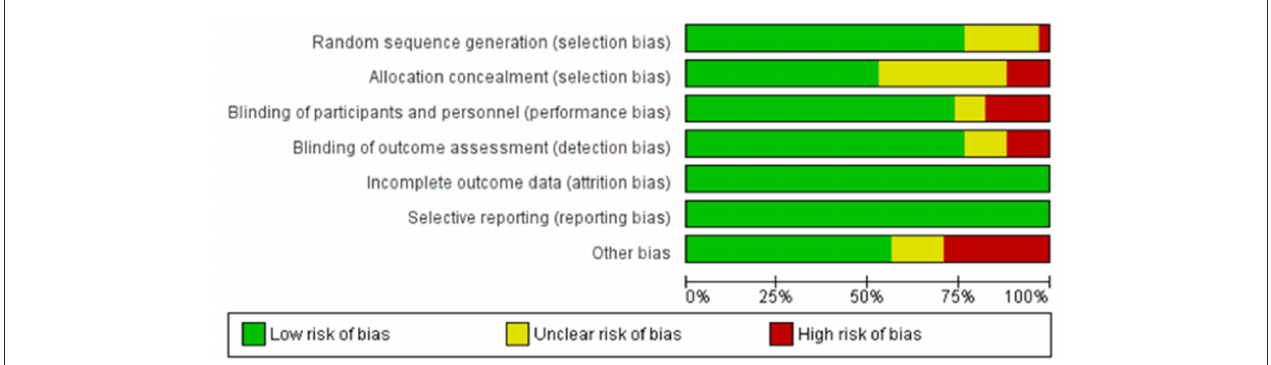
FIGURE 3 | Summary Graph for the risk of bias in included studies. By using the data that is used to create the summary table, this graph gives a broad view of the risk of bias in the included randomized controlled trials in the review. Green color denotes low risk of bias, while red color signifies an important risk of bias. Yellow indicates that the risk of bias is unclear, due to insufficient